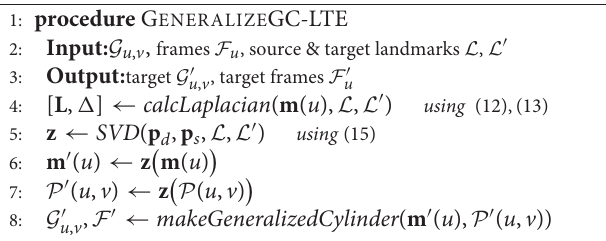
Algorithm 4 Generalization of GC using